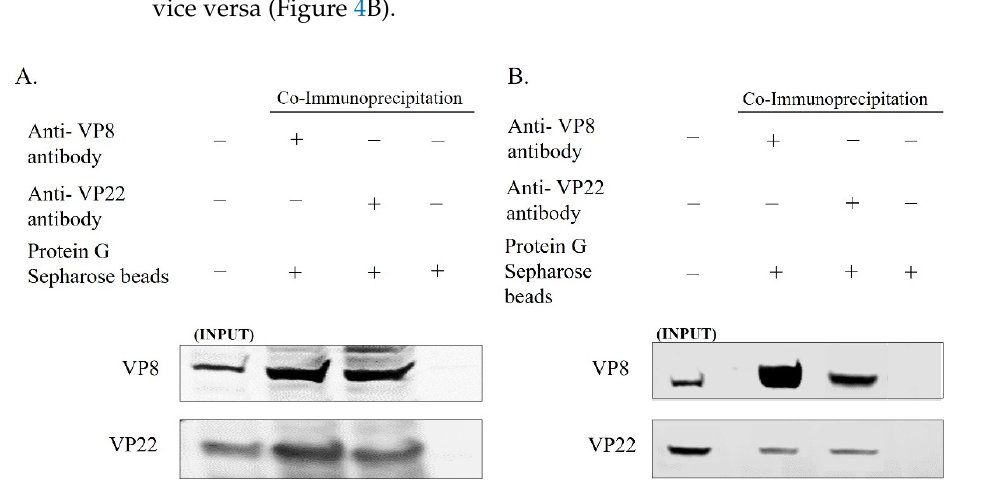
Figure 4. VP8 and VP22 interact during BoHV-1 infection. MDBK cells were infected with wild-type BoHV-1 at an MOI of 3 and harvested 8 h post-infection (primary enveloped virus; ( A )) or 18 h post infection (mature virus; ( B )). Lysates were generated and incubated with mouse VP8-specific monoclonal antibodies or rabbit VP22-specific polyclonal antibodies, followed by Protein Sepharose G beads. VP8 and VP22 were detected by Western blotting with monoclonal anti-VP8 and rabbit anti-VP22 antibodies, followed by IRDye 680RD goat anti-mouse IgG and IRDye 800RD goat anti-rabbit IgG, respectively. Immunoprecipitation of VP8 with VP22—and vice versa—is shown for both primary enveloped ( A ) and mature ( B ) virus.